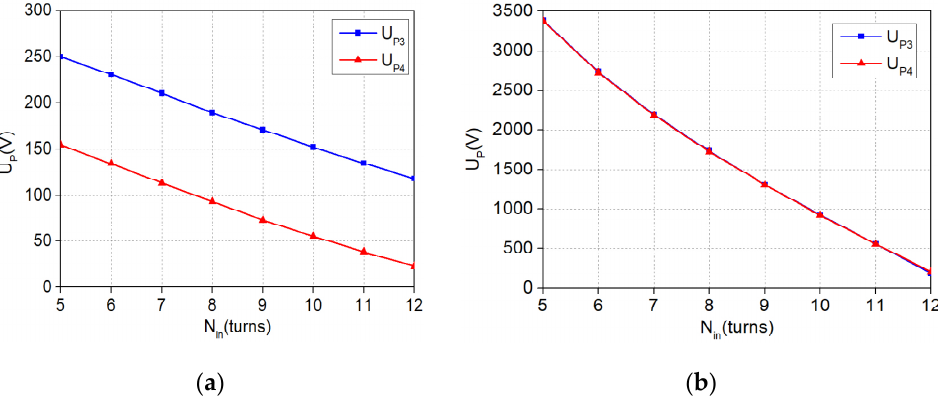
Figure 8. The variation of system operating frequency with N in and R eq . ( a ) The variation of f 1 with N in and R eq . ( b ) The variation of f 2 with N in and R eq .